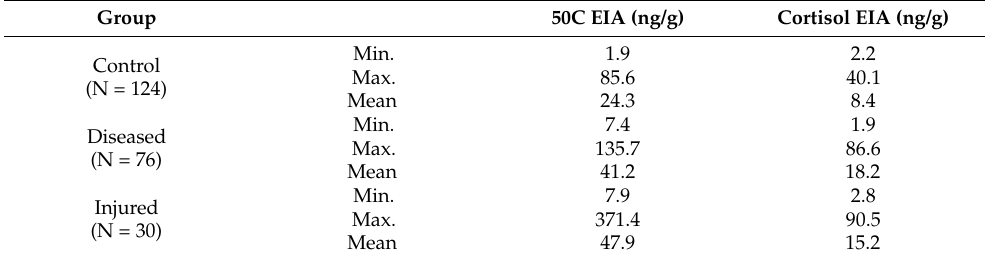
Table A5. Summary statistics for FCM (faecal cortisol metabolite) values (ng/g) measured by 50c and cortisol EIAs (enzyme immunoassays) for females and males in the control, diseased and injured groups. 50c EIA (ng/g)